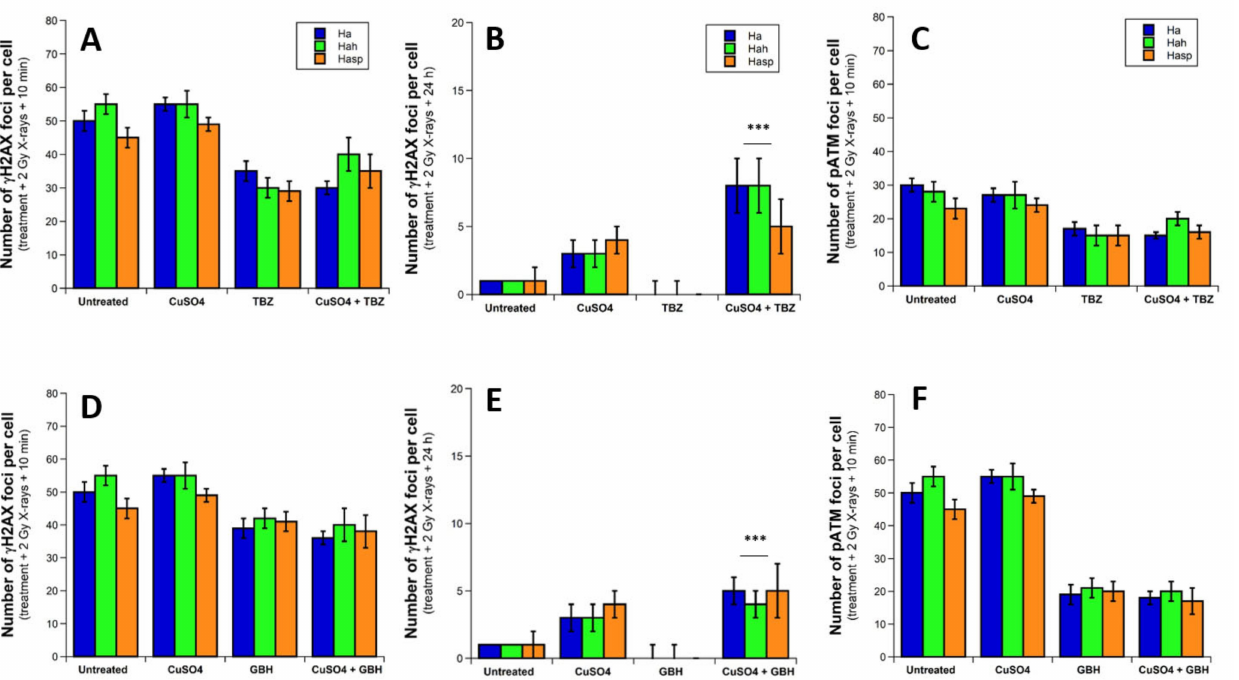
Figure 9. γ H2AX and pATM foci from brain astrocytes exposed to CuSO 4 and/or TBZ or GBH. Indicated cells were exposed to 24 h incubation with the indicated metal, pesticide, metal+pesticide, or 99% purified (metal + pesticide) complexes solutions, then irradiated at 2 Gy X-rays and incubated for up to 24 h for repair. “Untreated” mention means that neither pesticide nor metal were applied to cells before irradiation. The number of γ H2AX foci per cell was assessed at 10 min post-irradiation ( A , D ) and at 24 h post-irradiation ( B , E ), and the number of pATM foci per cell was assessed at 10 min post-irradiation ( C , F ) for TBZ and GBH, respectively. Each plot represents the mean ± standard error (SEM) of three replicates. Three asterisks represent significant differences from GBH mean value with p <